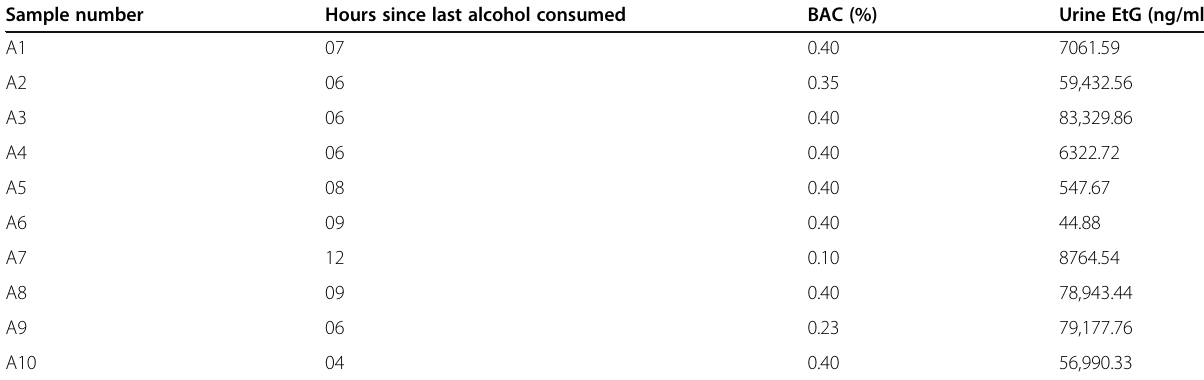
Table 3 Analyzed urine samples and their breath test values Sample number